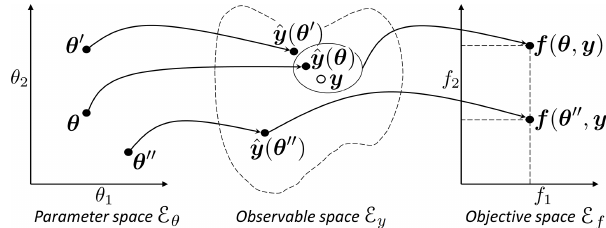
Figure 1. Notations to describe a model calibration, where θ is a vector from the parameter space E θ , y is a vector of observed values in the observable space E y and f ( θ , y ) is an objective vector in the objective space E f .